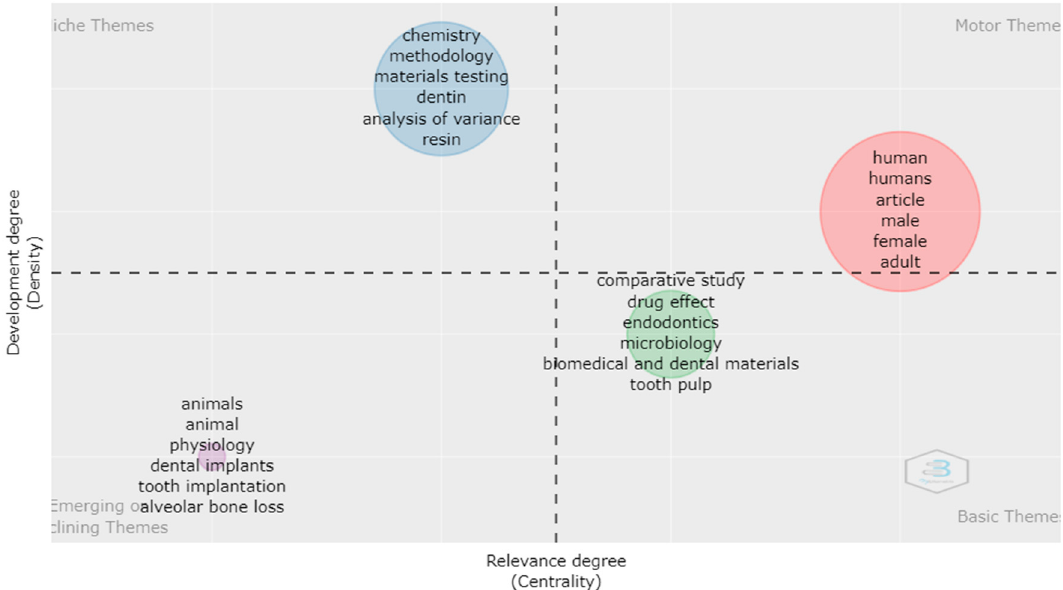
Figure A4. Conceptual Structure. Latin American Dentistry Thematic Map (1996–2020) generated with Bibliometrix [30]. Sort on: Cited by (highest)-First 2000 document results retrieved. Field: Keyword Plus, Number of words (560), Min cluster frequency (1–5), Number of labels (0–6), and Label size (0–0,3). Scopus Search Query: SUBJAREA (dent) AND (LIMIT-TO (AFFILCOUNTRY, “Brazil”) OR LIMIT-TO (AFFILCOUNTRY, “Chile”) OR LIMIT-TO (AFFILCOUNTRY, “Mexico”) OR LIMIT-TO (AFFILCOUNTRY, “Colombia”) OR LIMIT-TO (AFFILCOUNTRY, “Argentina”) OR LIMIT-TO (AFFILCOUNTRY, “Cuba”) OR LIMIT-TO (AFFILCOUNTRY, “Peru”) OR LIMIT-TO (AFFILCOUNTRY, “Venezuela”) OR LIMIT-TO (AFFILCOUNTRY, “Puerto Rico”) OR LIMIT-TO (AFFILCOUNTRY, “Uruguay”) OR LIMIT-TO (AFFILCOUNTRY, “Guatemala”) OR LIMIT-TO (AFFILCOUNTRY, “Ecuador”) OR LIMIT-TO (AFFILCOUNTRY, “Costa Rica”) OR LIMIT-TO (AFFILCOUNTRY, “Paraguay”) OR LIMIT-TO (AFFILCOUNTRY, “Trinidad and Tobago”) OR LIMIT-TO (AFFILCOUNTRY, “Dominican Republic”) OR LIMIT-TO (AFFILCOUNTRY, “Jamaica”) OR LIMIT-TO (AFFILCOUNTRY, “Panama”) OR LIMIT-TO (AFFILCOUNTRY, “Belize”) OR LIMIT-TO (AFFILCOUNTRY, “Nicaragua”)) AND (LIMIT-TO (PUBYEAR, 2020) OR LIMIT-TO (PUBYEAR, 2019) OR LIMIT-TO (PUBYEAR, 2018) OR LIMIT-TO (PUBYEAR, 2017) OR LIMIT-TO (PUBYEAR, 2016) OR LIMIT-TO (PUBYEAR, 2015) OR LIMIT-TO (PUBYEAR, 2014) OR LIMIT-TO (PUBYEAR, 2013) OR LIMIT-TO (PUBYEAR, 2012) OR LIMIT-TO (PUBYEAR, 2011) OR LIMIT-TO (PUBYEAR, 2010) OR LIMIT-TO (PUBYEAR, 2009) OR LIMIT-TO (PUBYEAR, 2008) OR LIMIT-TO (PUBYEAR, 2007) OR LIMIT-TO (PUBYEAR, 2006) OR LIMIT-TO (PUBYEAR, 2005) OR LIMIT-TO (PUBYEAR, 2004) OR LIMIT-TO (PUBYEAR, 2003) OR LIMIT-TO (PUBYEAR, 2002) OR LIMIT-TO (PUBYEAR, 2001) OR LIMIT-TO (PUBYEAR, 2000) OR LIMIT-TO (PUBYEAR, 1999) OR LIMIT-TO (PUBYEAR, 1998) OR LIMIT-TO (PUBYEAR, 1997) OR LIMIT-TO (PUBYEAR, 1996)). Search date on Scopus database: 6 June 2022. Search: 35,032 document results.